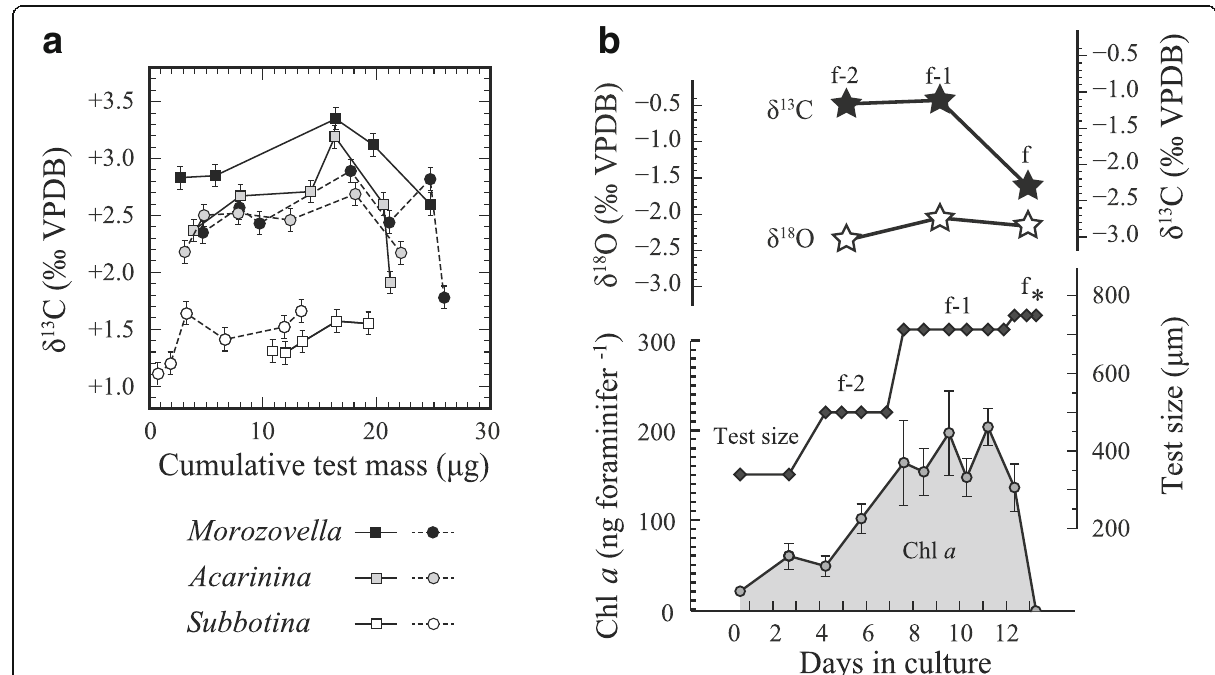
Fig. 16 Comparison of isotopic results for Eocene species and modern cultured photosymbiotic species. a Chamber-by-chamber δ 13 C versus cumulative test mass of Eocene species. The same shade is used for symbols of the same species (black: Morozovella crater ; gray: Acarinina cuneicamerata ; white: Subbotina eocaena ). Data for the same individual are connected in ontogenetic order. Error bars represent analytical errors (±0.1 ‰ ). Each individual test was dissected into chambers using a micro-blade (e.g., Takagi et al. 2015; 2016b), then analyzed by a customized continuous-flow mass spectrometry system that can measure micro-volume carbonate as small as a single chamber (Ishimura et al. 2004, 2008). Symbiotic species Morozovella and Acarinina tended to show slight positive shifts until the penultimate chamber and then the final chamber showed drastically more 13 C-depleted δ 13 C (values 0.5 – 1.0 ‰ ). In contrast to these species, Subbotina showed comparatively 13 C-depleted δ 13 C values through its ontogeny, which is in good agreement with the known non-symbiotic nature of this species. b Growth and test isotopic results for the modern symbiotic species Globigerinoides sacculifer cultured in a laboratory (Takagi et al., 2018). Chlorophyll- a content of the individual was estimated using an and δ 18 O were analyzed. Data are partly from Takagi et al. (2016a). The decrease of δ 13 C was accompanied by a decrease in (or almost